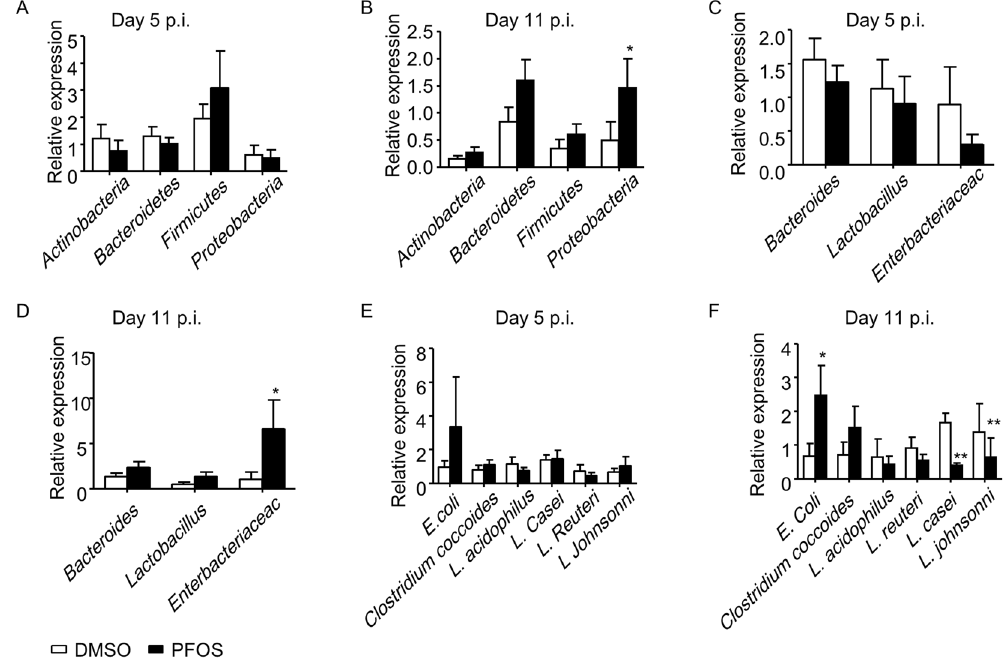
Figure 6. PFOS treatment results in dysbiosis at late phase of C. rodentium infection. Wild-type mice were treated with PFOS and infected with C. rodentium as described in Fig. 1. ( A , C and E ) The expression of indicated commensals in the feces of PFOS treated mice and control at day 5 post C. rodentium infection (p.i.) was analyzed by real-time PCR. ( B , D and F ) The expression of indicated commensals in the feces of PFOS treated mice and control at day 11 post C. rodentium infection (p.i.) was analyzed by real-time PCR. Statistical analyses were performed using Mann-Whitney unpaired U test. Error bars represent SEM. Data were pooled from three independent